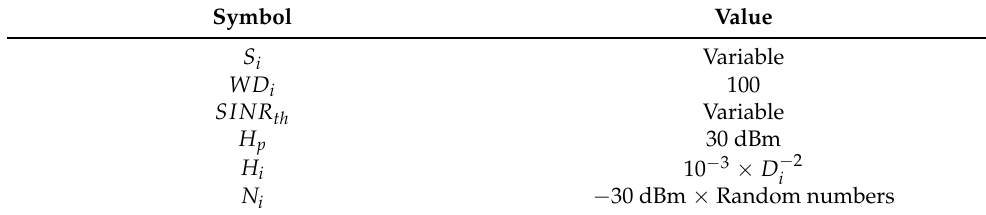
Table 1. Simulation parameter values.